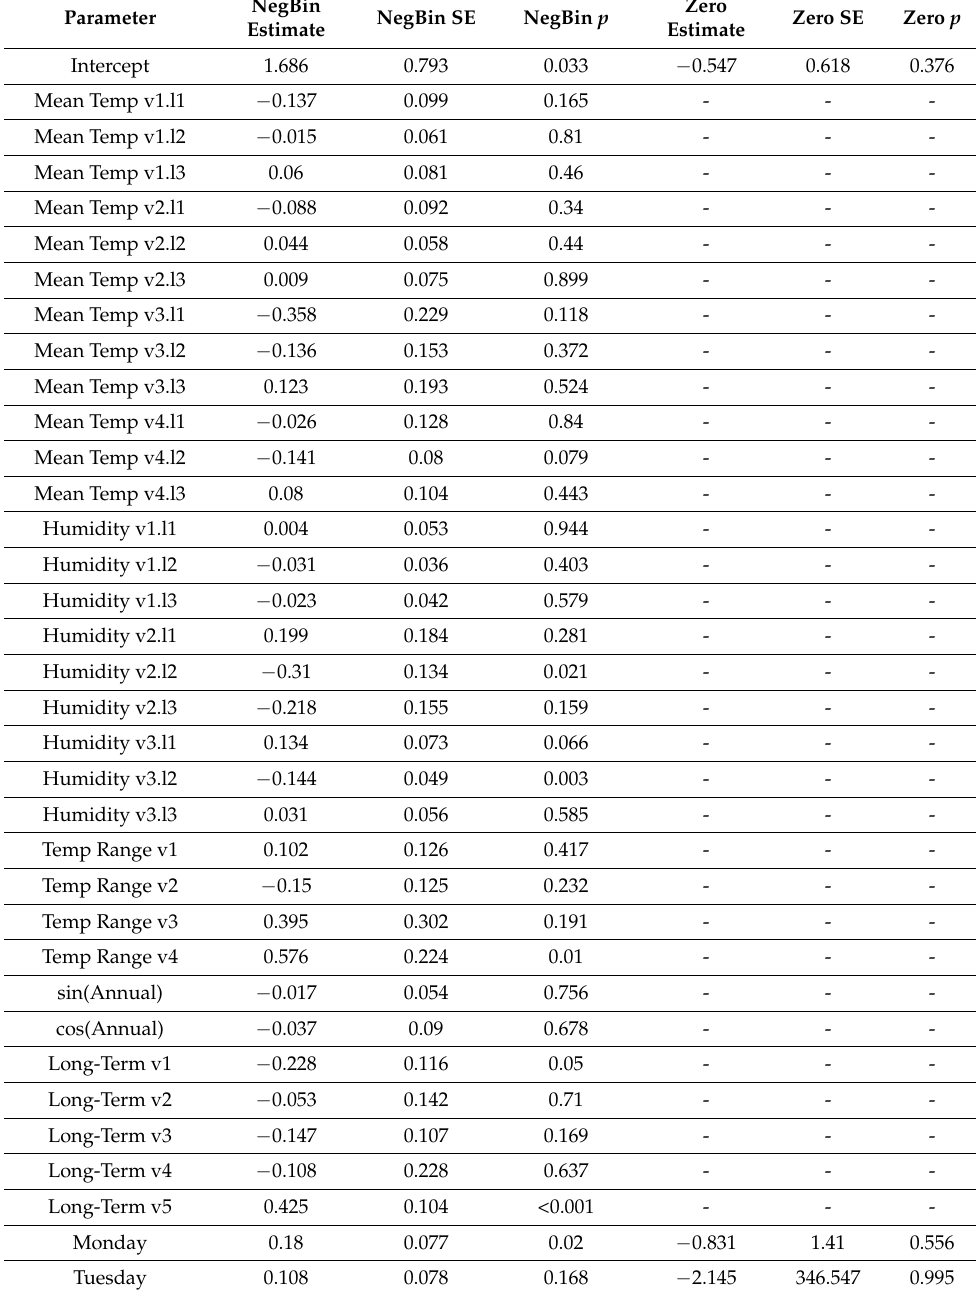
Table A1. Model parameter estimates, standard errors (SE) and p -values for the negative binomial component of the model which corresponds to the log-rate of admissions (NegBin) and the zero- inflated binomial component of the model which corresponds to the log-odds ratio of whether there will be any hospital admissions for a given day (Zero). The overdispersion for the negative binomial component is 7.41. “v1” corresponds to the gradient of the exposure-response association in the first interval of a spline, “v2” to that in the second interval, and so on. “l1” corresponds to the gradient of the lagged association in the first interval of a spline, “l2” to that in the second interval, and so on. A value of 0 would represent no association or lagged response respectively in the given spline